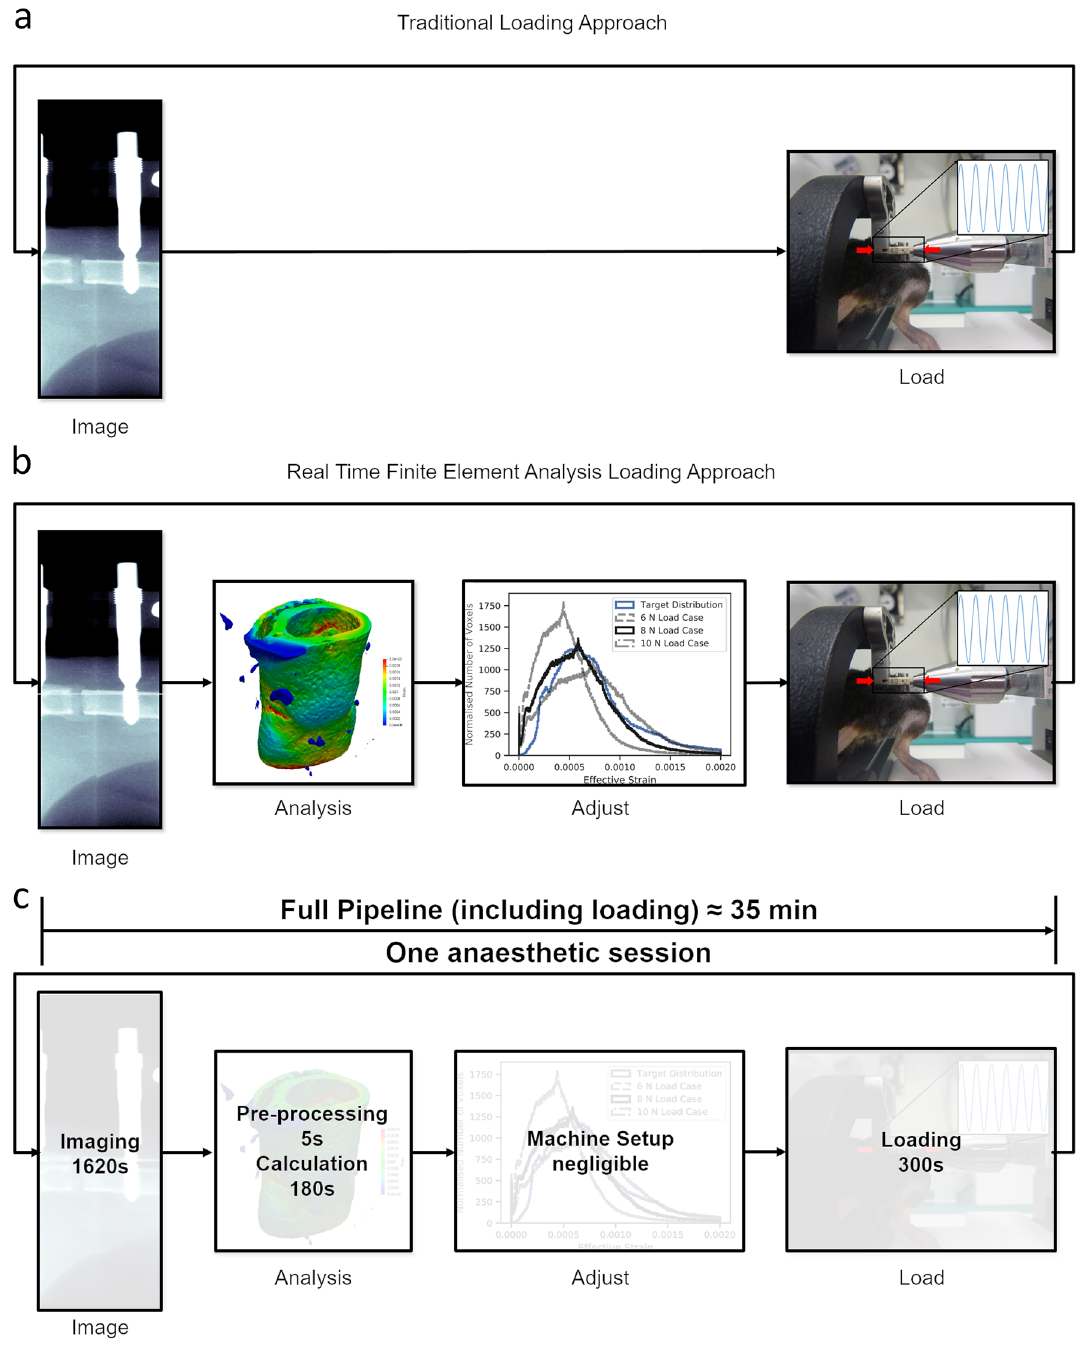
Figure 1. ( a ) A traditional loading experiment images the animal and uses a loading protocol decided on before the experiment has begun. ( b ) The rtFE approach incorporates the simulation and adjustment of the loading parameters to ensure a targeted mechanical stimulation at each time point for the animal. ( c ) When incorporated within the experimental pipeline, appropriate implementation of the rtFE will allow the full process to be incorporated in a single anaesthetic